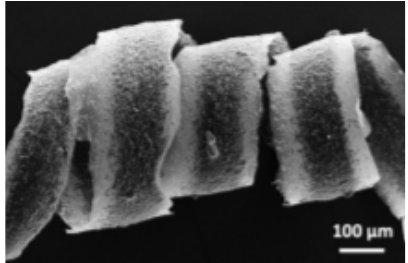
Figure 9. SEM micrographs of helical wet-spun fibers (adapted from [21], published by Beilstein- Institut Zur Forderung der Chemischen Wissenschaften, 2020). Institut Zur Forderung der Chemischen Wissenschaften,